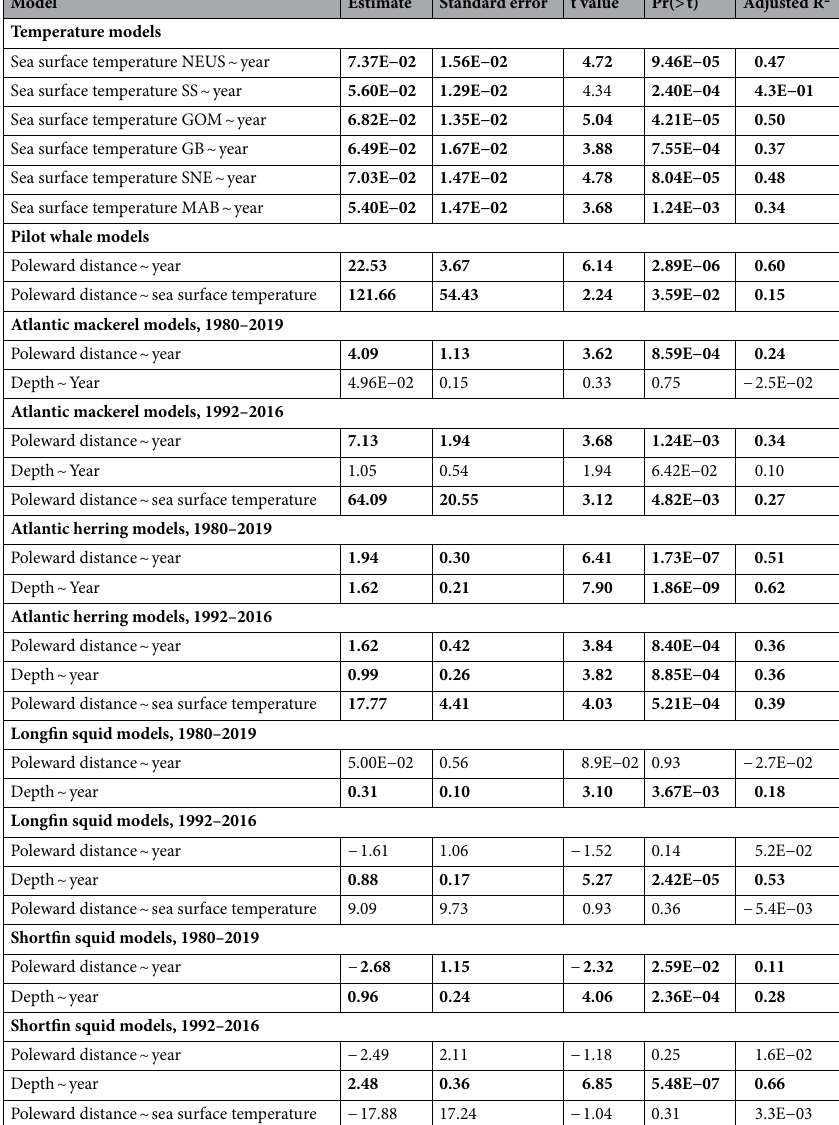
Table 1. Estimated parameters of linear regressions used to evaluate changes in the poleward distance and depth of the center of distribution for long-finned pilot whales, Atlantic mackerel, Atlantic herring, longfin squid and shortfin squid from 1992 to 2016. Significant relationships (p < 0.05) are shown in bold. MAB = Mid- Atlantic Bight; SNE = Southern New England; GB = Georges Banks; GOM = Gulf of Maine; SS = Scotian